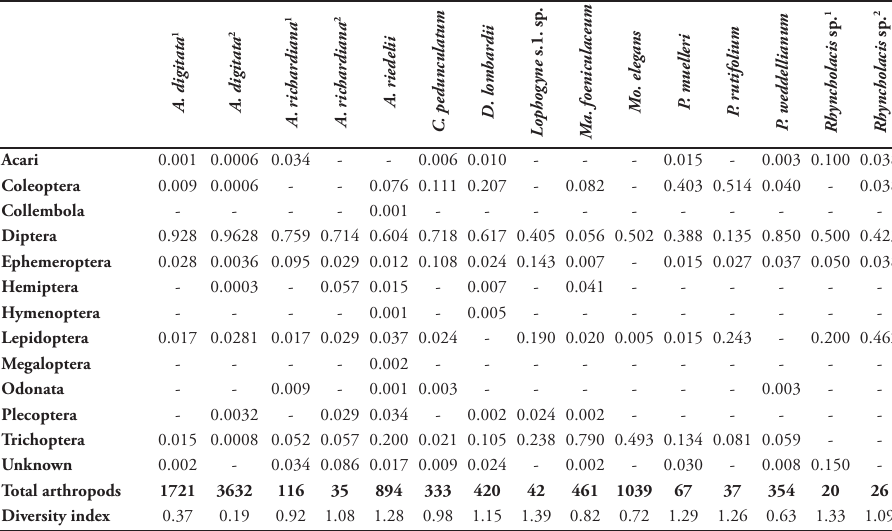
Table 3. Proportion and total number of arthropod specimens for each order, and the Shannon-Weiner diversity index score of each sample of